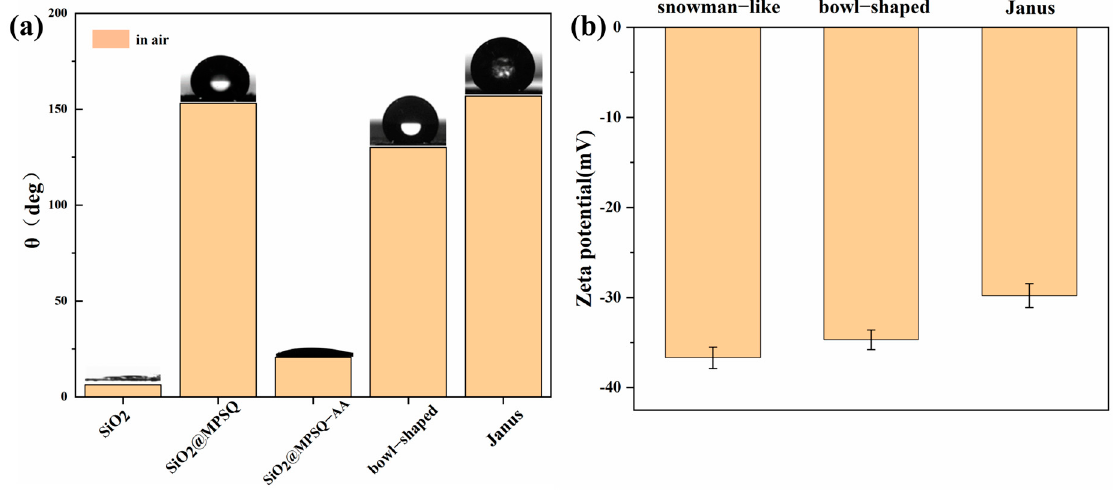
Figure 7. ( a ) Contact angles of the prepared particles and ( b ) corresponding zeta potentials of three particle types measured in